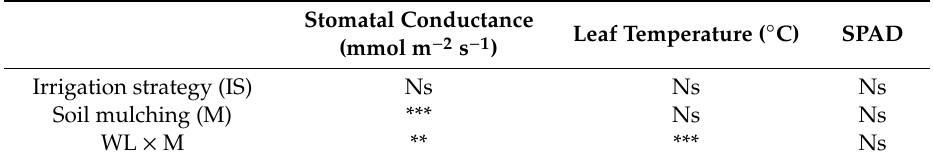
Table 4. Experiment 2: E ff ect of the irrigation strategy and soil mulching on the physiological parameters of lettuce. Significance codes: *, significant at p ≤ 0.05; **, significant at p ≤ 0.01; ***, significant at p ≤ 0.001, “Ns” = not significant.